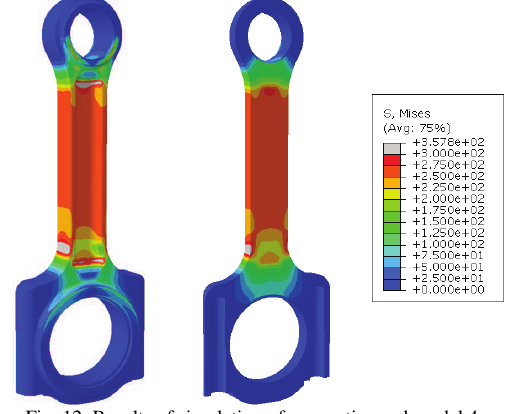
Fig. 12. Results of simulation of connecting rod model 4